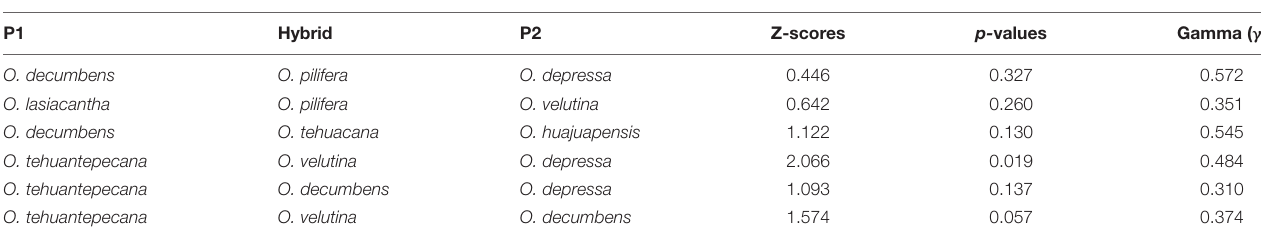
FIGURE 5 | All individual hybridization tests made with MDC; on the left side is the species tree, and on the right side is the inferred reticulation with specific putative hybrids. Inheritance probabilities are indicated before each arrow. (A–E) O. tehuacana best MDC network. (F–H) O. pilifera best MDC network. TABLE 4 | Results from hybridization detection in HyDe with positive